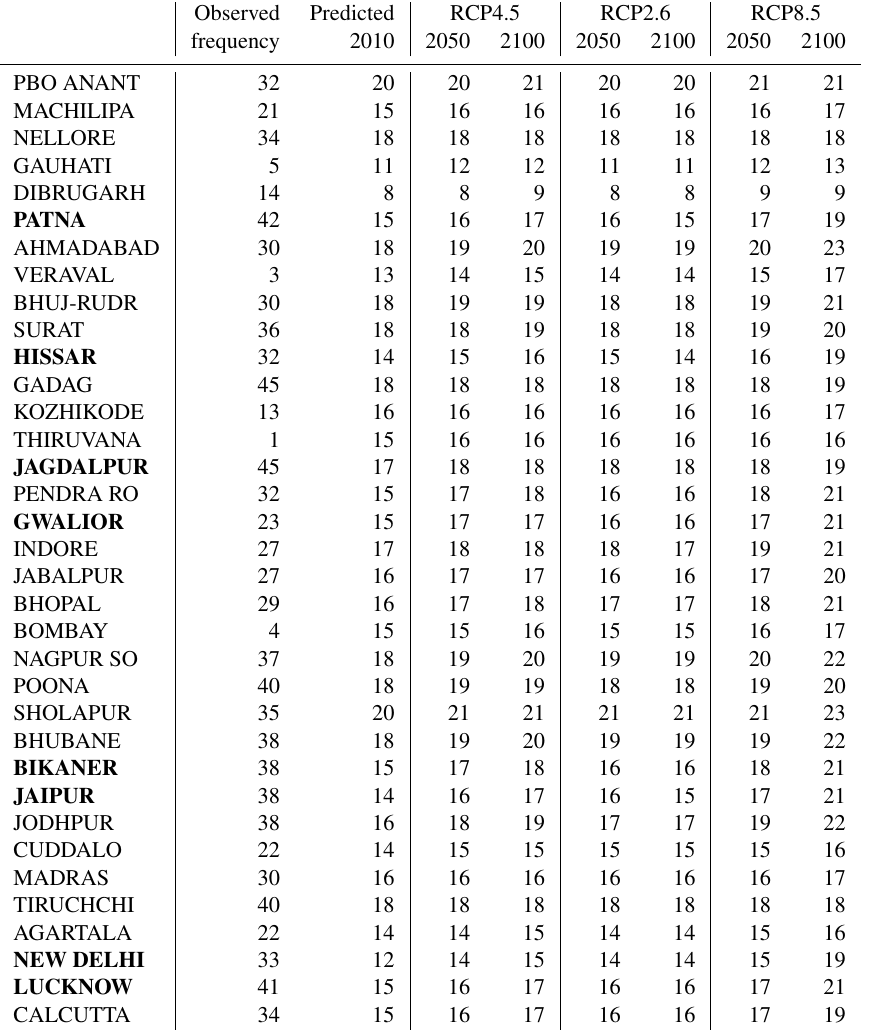
Table 2. Estimated probability (expressed in %) for duration greater than 5 consecutive days with temperatures exceeding 35 ◦ C during February–April. The observed frequency was based on the number of February–April heatwaves lasting more than 5 days divided by the total number of heatwaves in February–April. The location names in bold font mark stations within the IGP